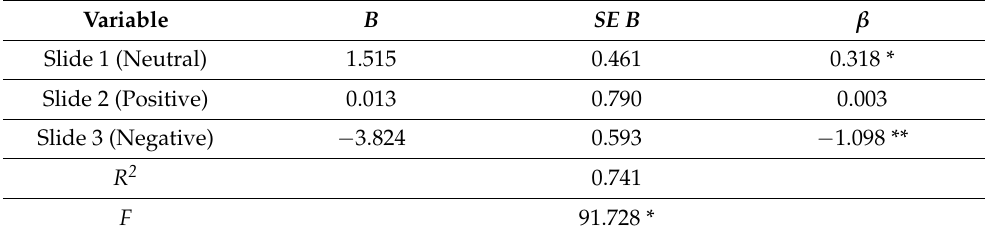
Table 7. Simple linear regression analysis predicting the suicide